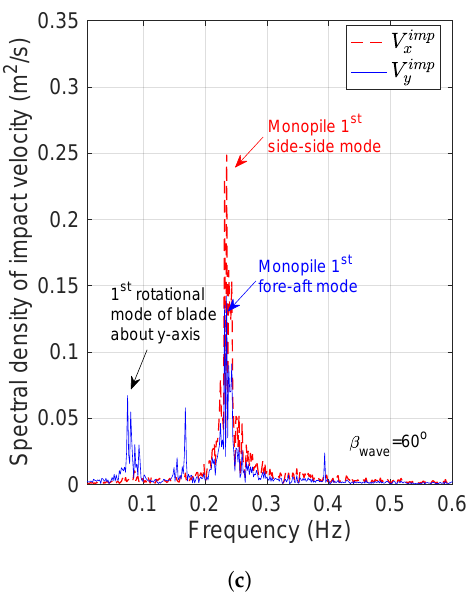
Figure 11. Spectral density curve for V imp x and V imp y for load case H s = 2 m, T p = 4 s, U w = 8 m/s and for different wind–wave misalignment ( a ) β wave = 0° ( b ) β wave = 30° ( c ) β wave =